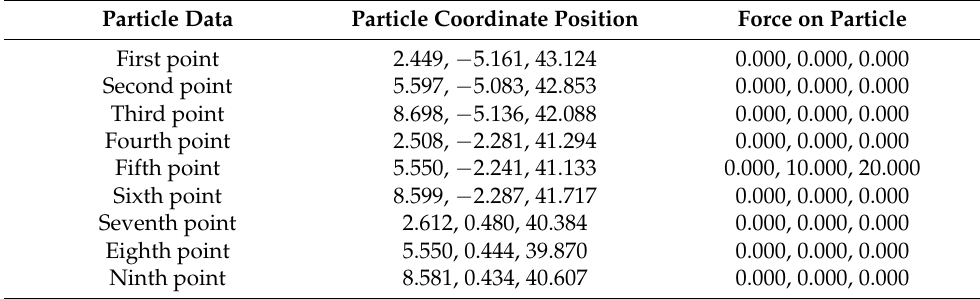
Table 3. Instantaneous position and force of the